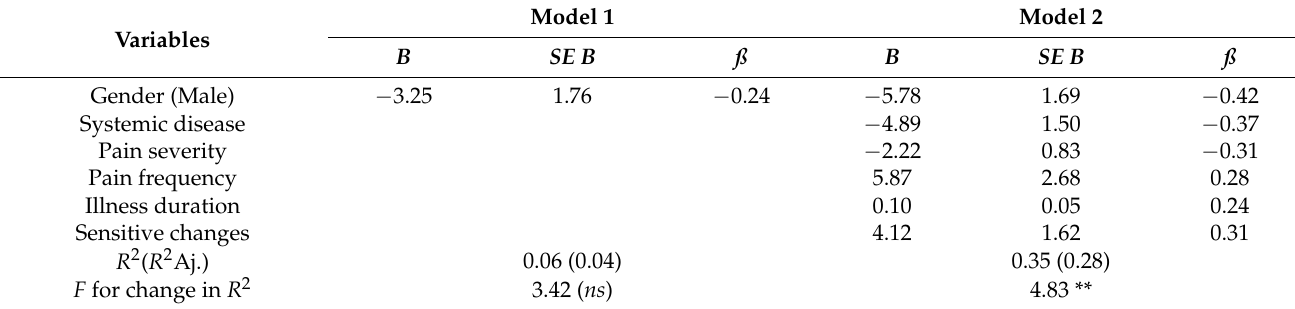
Table 5. Variables that contribute to pain acceptance in headache